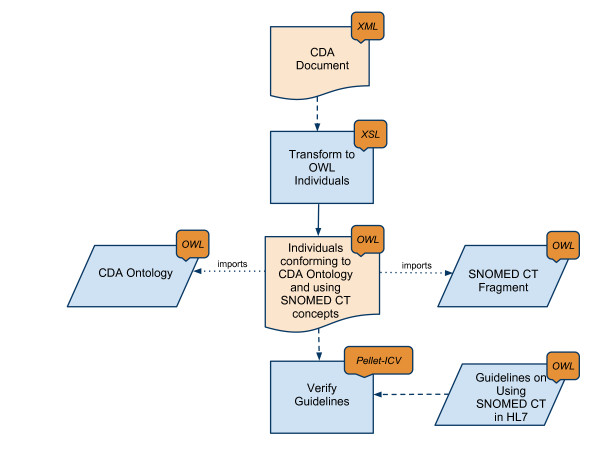
Used Method Verifying Guidelines SNOMED CT®. The figure describes a top level view of the used method to validate CDA documents using semantic technologies.